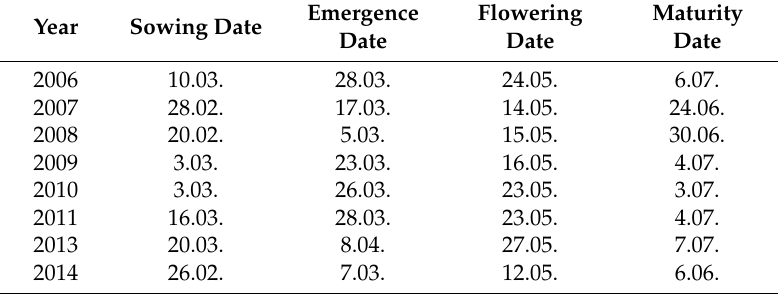
Table 3. The measured crop growth variables that were used for calibration and validation.